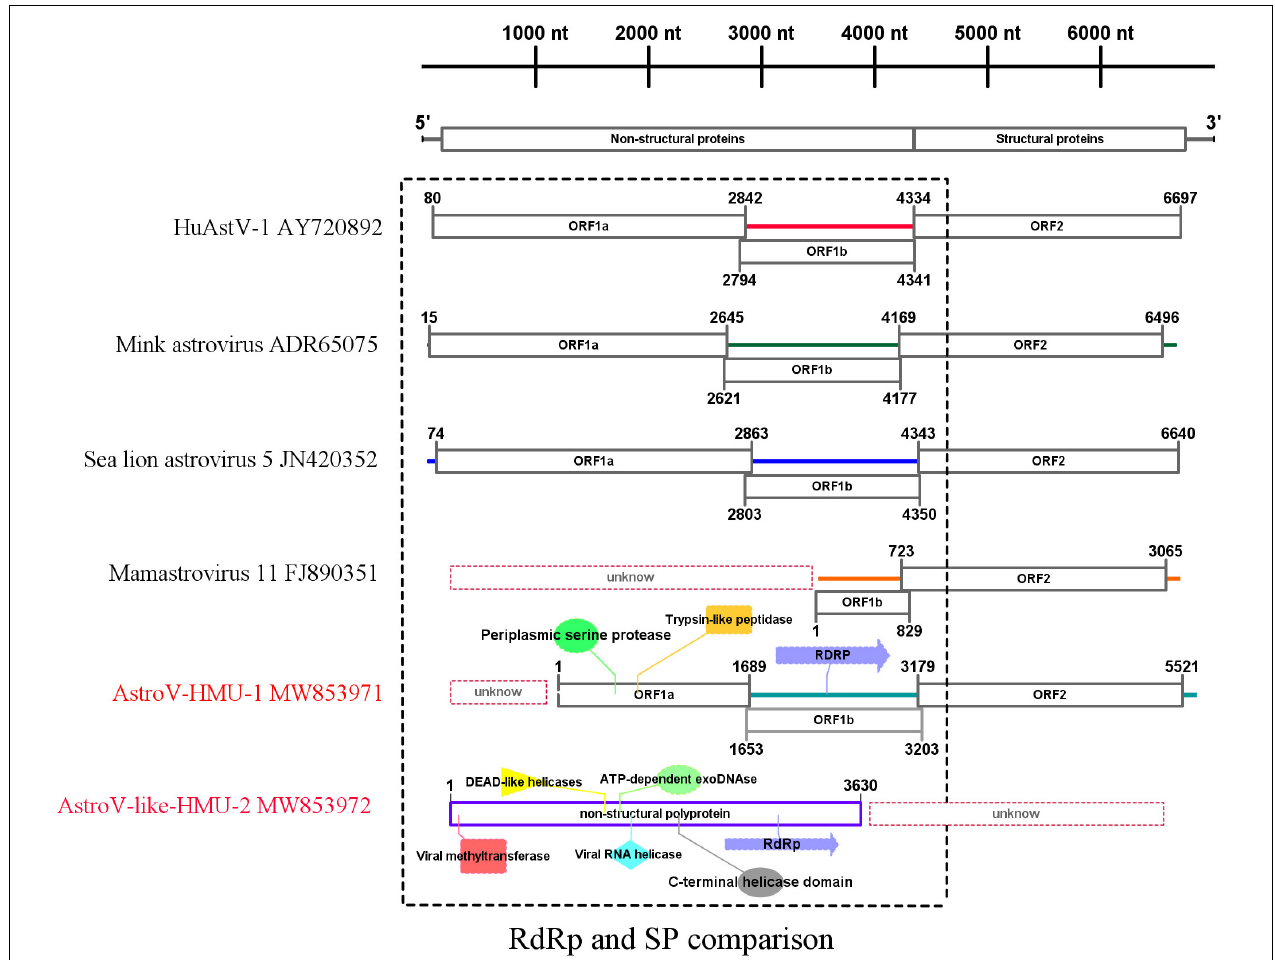
FIGURE 2 | Genome organization and comparison of related astroviruses. Novel astroviruses discovered in the present study are highlighted in red.